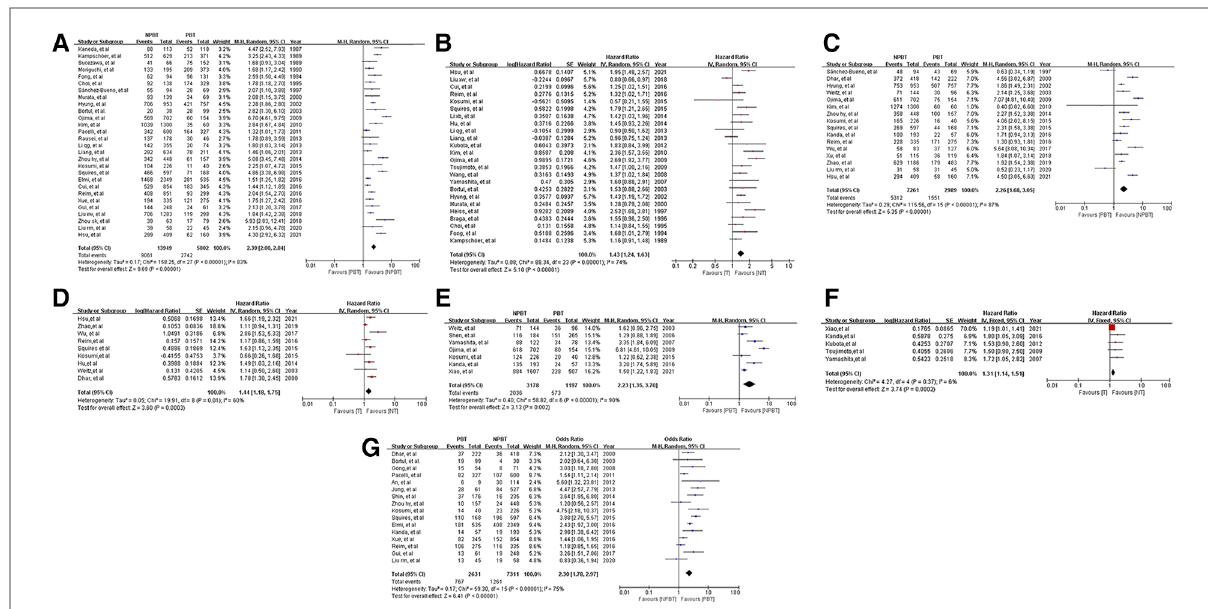
FIGURE 2 Forest plots and results of the meta-analysis of studies. ( A ) Forest plot of overall survival (OS) based on univariate results of studies. ( B ) Forest plot of OS based on multivariate results of studies. ( C ) Forest plot of disease-free survival (DFS) based on univariate results of studies. ( D ) Forest plot of DFS based on multivariate results of studies. ( E ) Forest plot of disease-speci fi c survival (DSS) based on univariate results of studies. ( F ) Forest plot of DSS based on multivariate results of studies. ( G ) Forest plot of postoperative complications based on results of